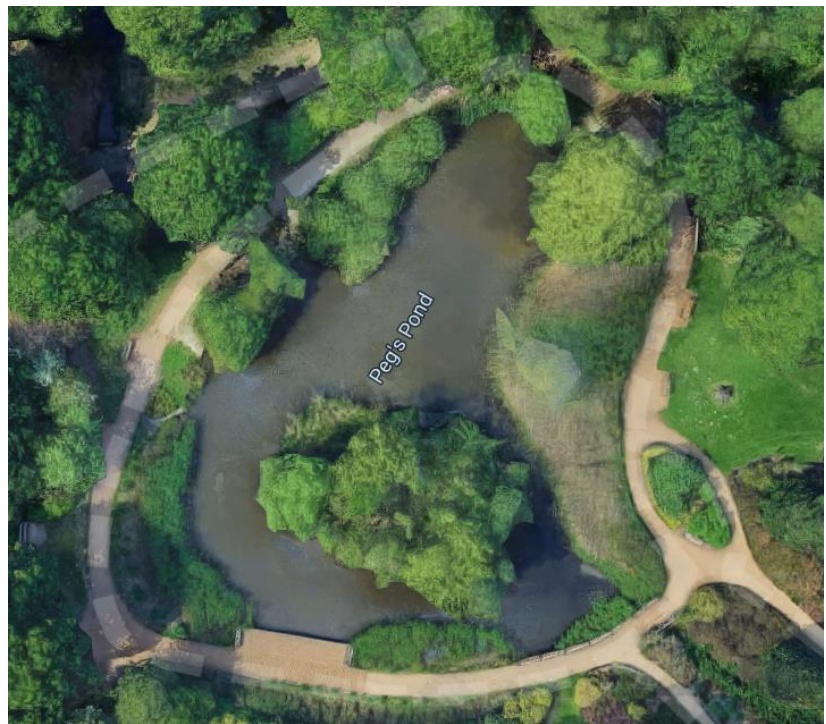
Figure 1. Google Maps view of Peg’s Pond with an area of open water of approximately 936 m 2 . Google (2022) Isabella Plantation, Richmond Park. Available at: http://maps.google.co.uk (Accessed: 26 July 2022).